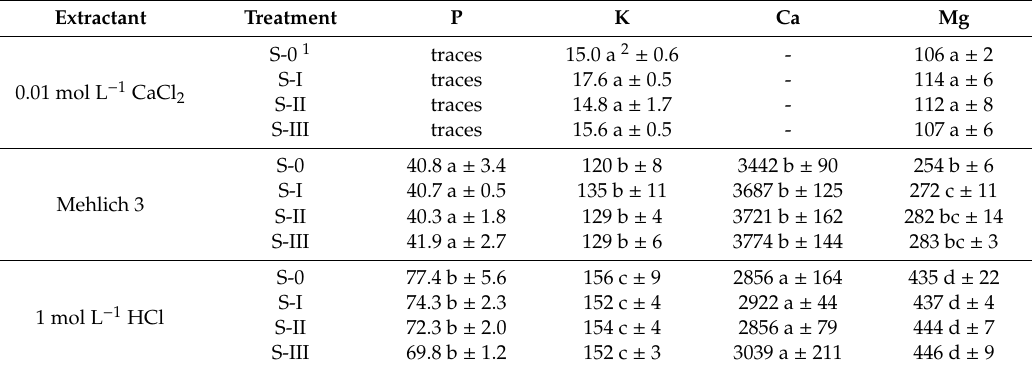
Table 6. Content of available forms of selected macroelements in heavy soil 60 days after sulfur introduction (mg kg − 1 d.m. ±